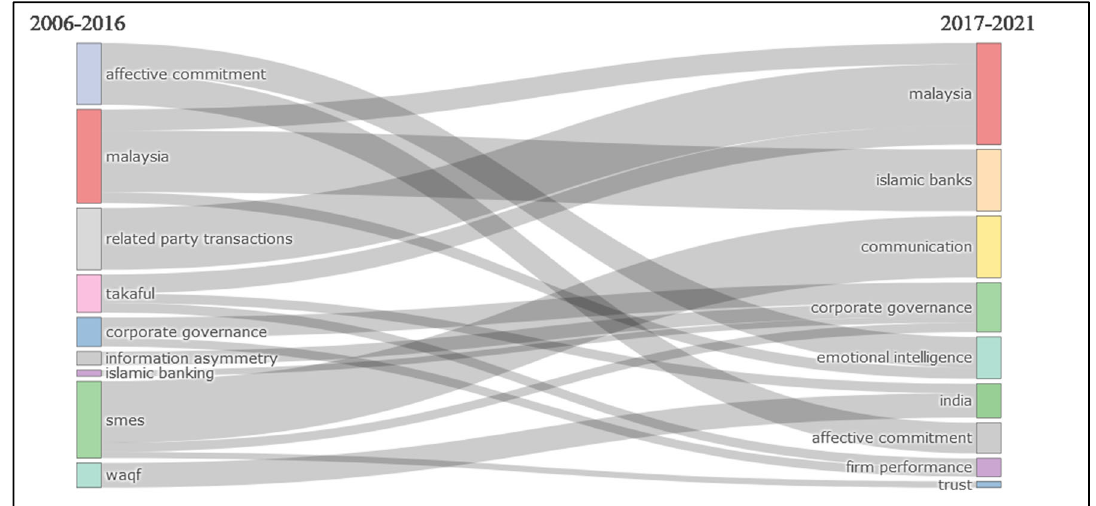
Figure 7. Thematic Evolution of Jurnal Pengurusan.